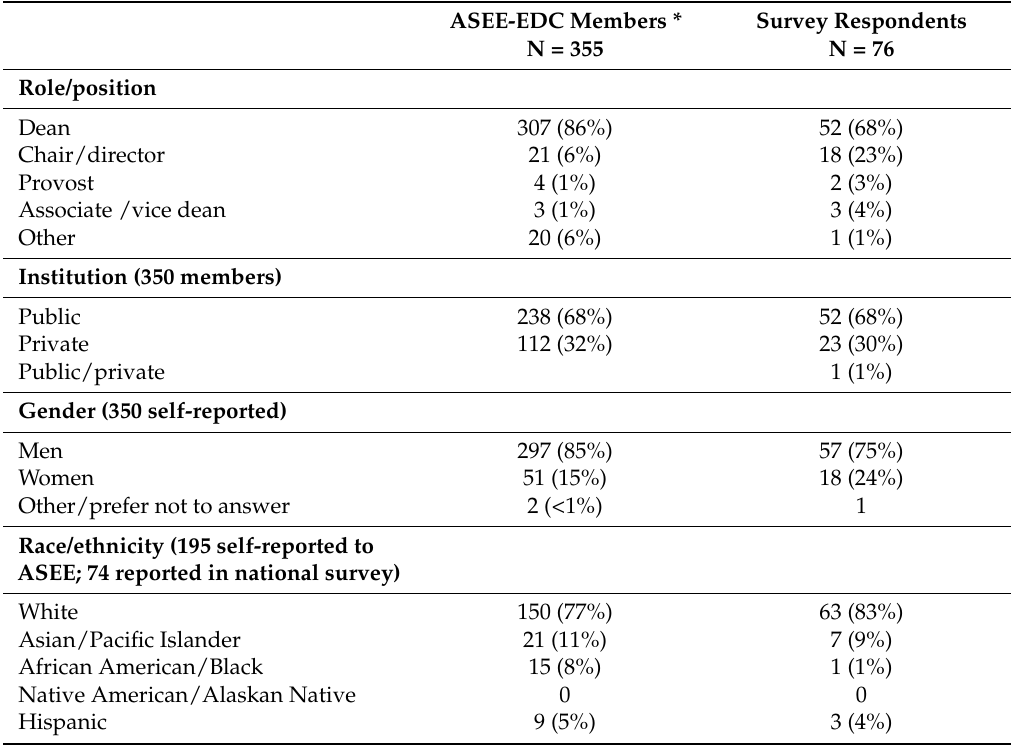
Table 1. Characteristics of American Society for Engineering Education (ASEE) leaders and respondents to survey of engineering education